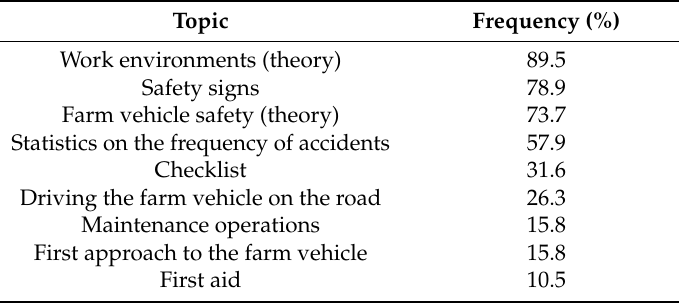
Table 2. Topics seen in the publications and their